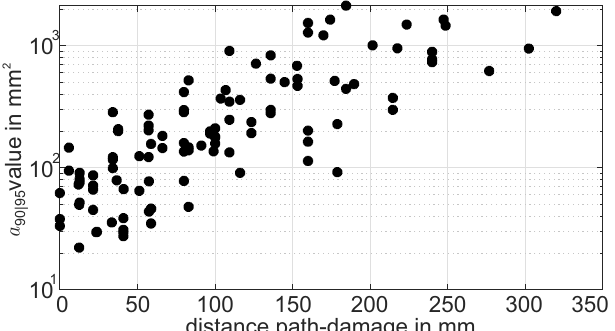
Figure 14. a 90 | 95 versus path absolute distance from the flaw as a 2D representation of Figure